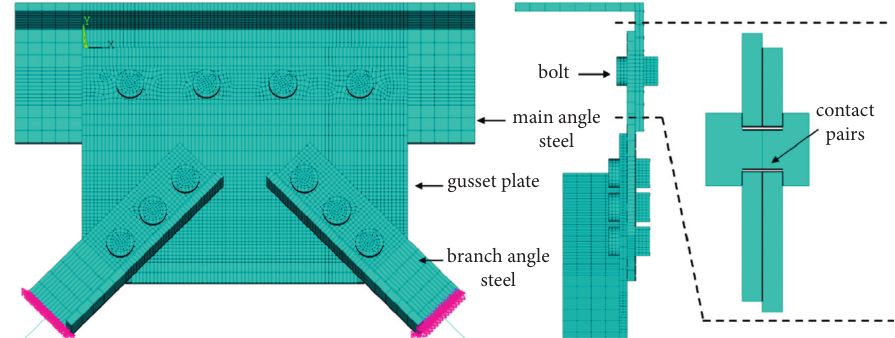
Figure 1: K-joint finite element